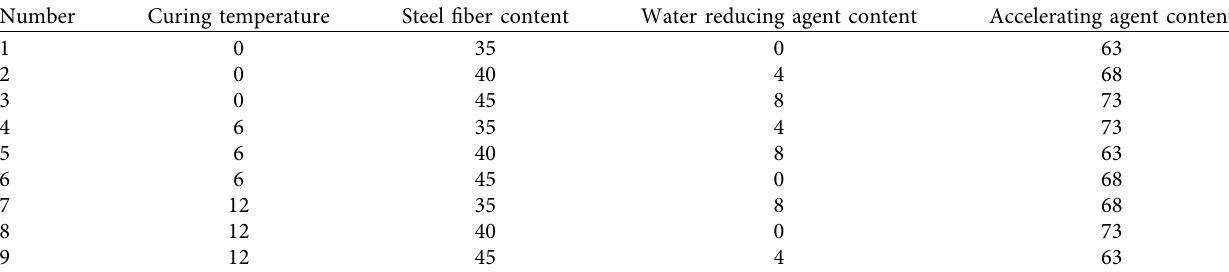
Table 5: Orthogonal test designs